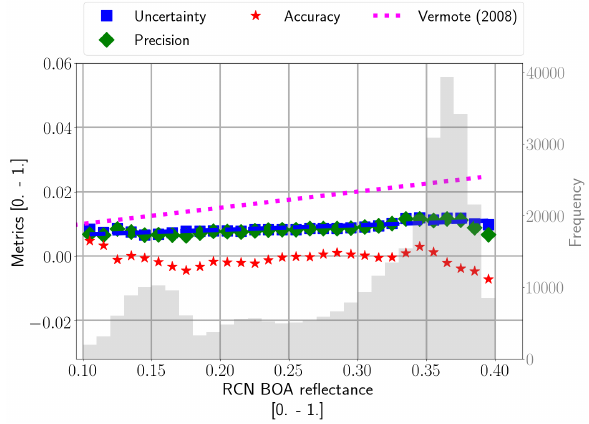
Figure 4. Accuracy (red star), precision (green diamond) and uncertainty (blue square) as a function of the reference value of DESIS surface reflectance for Gobabeb RadCalNet site. The number of pixels included in each bin are shown in the shadow histogram and in the right axis. Uncertainty fit is displayed as dotted blue